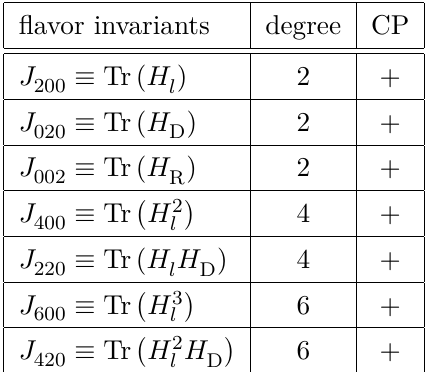
, q and q denote the degrees of D R l